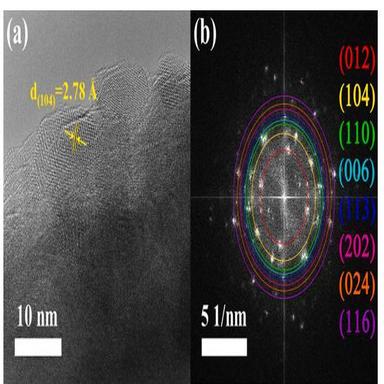
(a) HRTEM photograph and (b) corresponding SAED image of V2O3@CCN-composites.